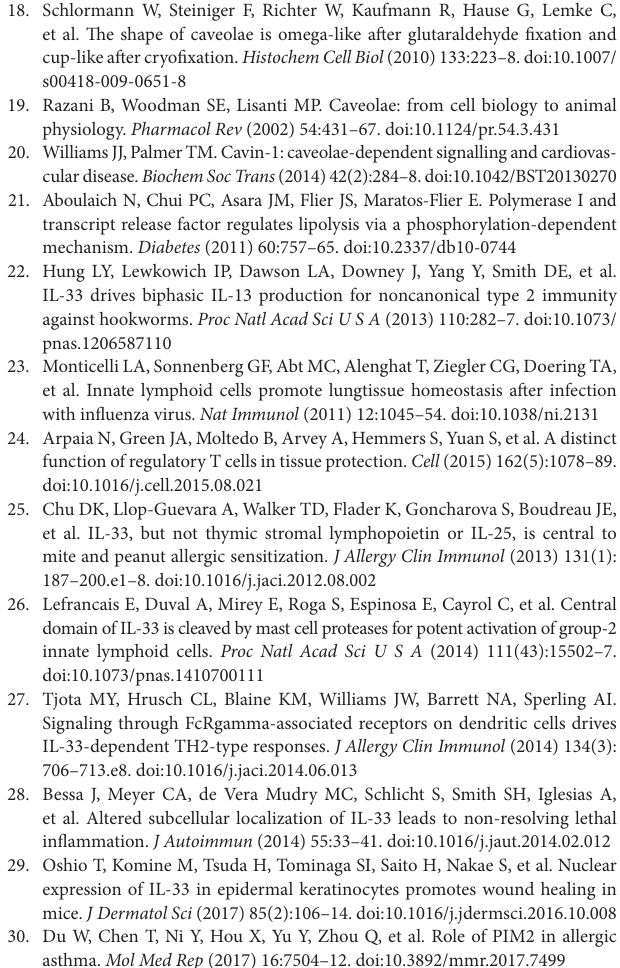
FigUre s1 | IL-33 interacts with polymerase I and transcript release factor (PTRF). Whole cell lysates from Flag-IL-33 and HA-PTRF transfected HBE cells